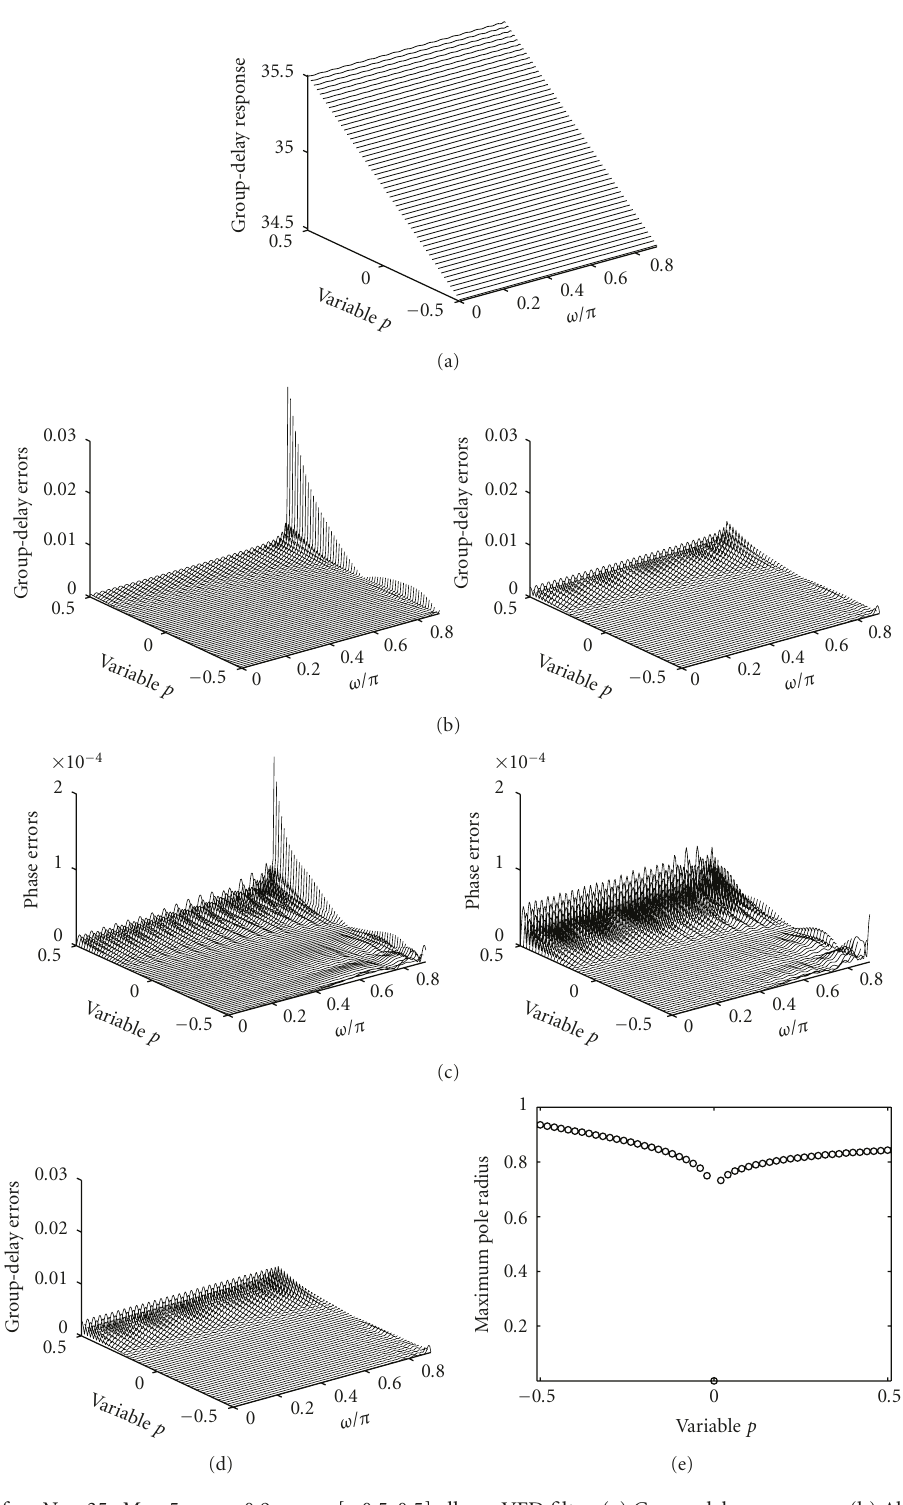
Figure 3: Design of an N = 35, M = 5, ω p = 0 . 9 π , p ∈ [ − 0 . 5,0 . 5] allpass VFD filter. (a) Group-delay responses. (b) Absolute group-delay errors (left: Deng’s LS design, right: proposed LS design). (c) Absolute phase errors (left: Deng’s LS design, right: proposed LS design). (d) Absolute group-delay errors of the proposed minimax design. (e) Maximum pole radius for p ∈ [ − 0 . 5,0 .